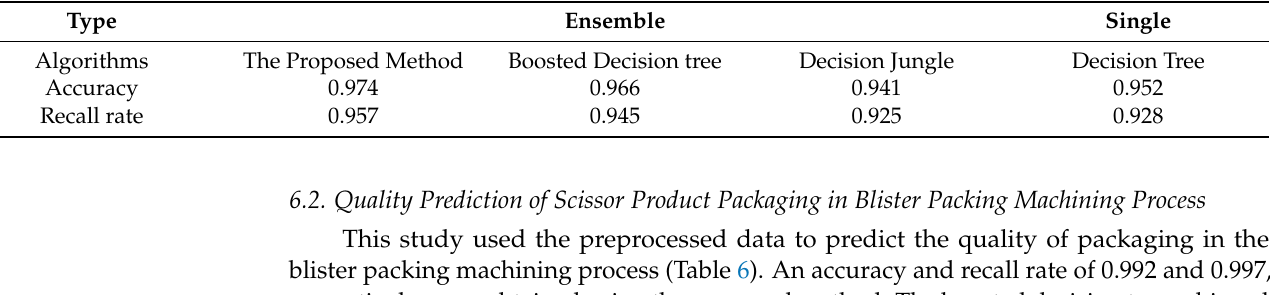
Table 5. Results of semiconductor